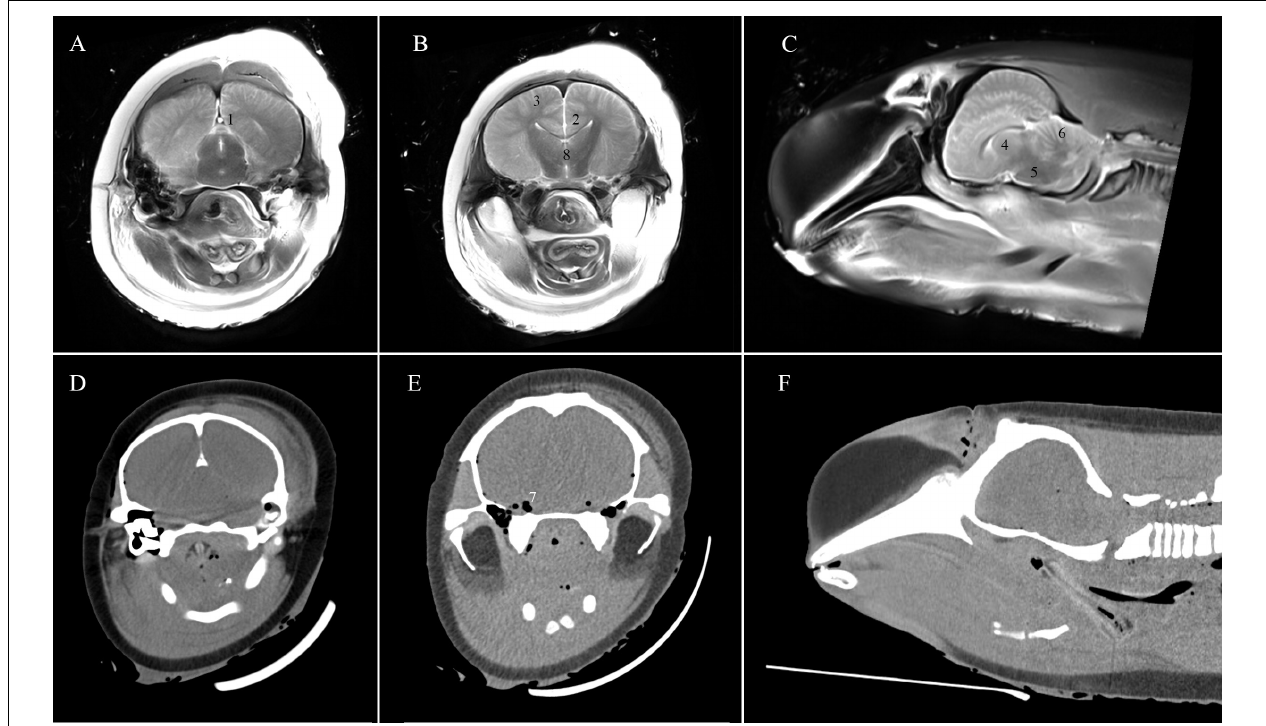
FIGURE 1 | T2w PMMR (A–C) and PMCT (D–F) images illustrating the eight regions of interest of the cetacean brain for the evaluation: (1) dorsal sagittal sinus; (2) ventricles; (3) grey and white matter junction; (4) basal ganglia; (5) brain stem; (6) cerebellum; (7) intracranial gas accumulation; (8) brain midline/symmetry.